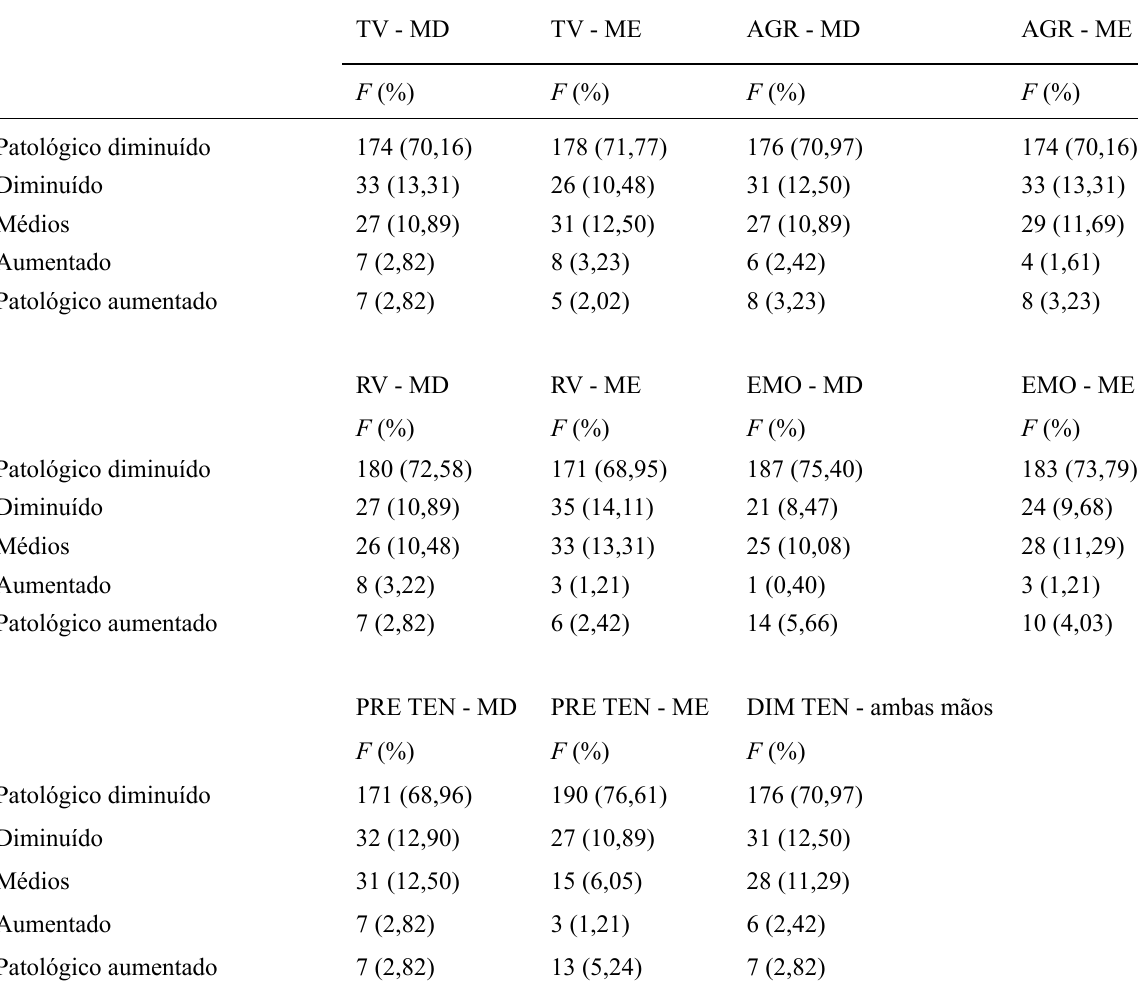
Estatísticas Descritivas a Frequência de Indivíduos nas Dimensões Teóricas do PMK (N=248) Categorias dos escores fatoriais